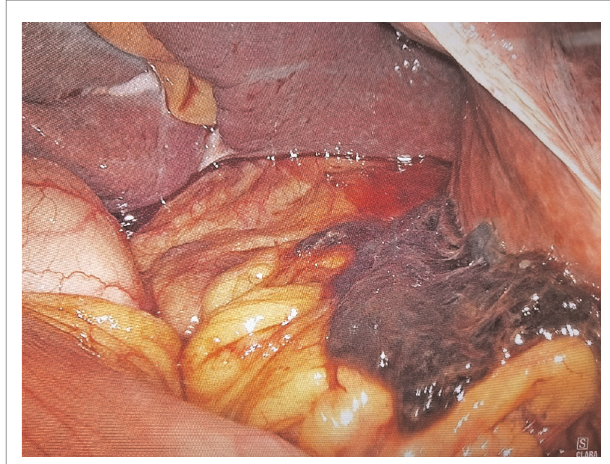
FIGURE 2 | Massive blood clot located in the hepatogastric space surrounded by dark red unclotted